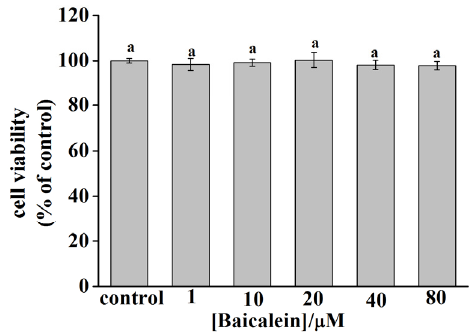
Figure 4. The cytotoxicity of baicalein in PC12 cells. Data are presented as the mean ± SEM of six independent experiments. The same letter “a” indicates no significant difference (P > 0.05).